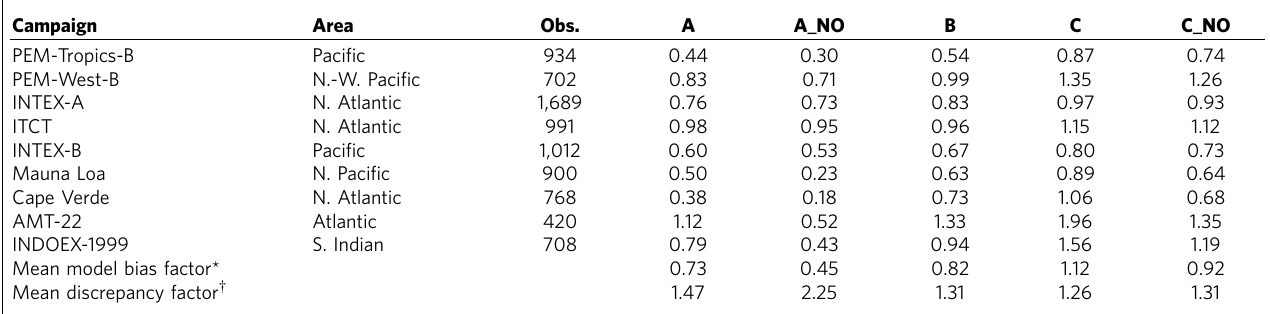
Table 5 | Measured CH 3 OH over oceans and model biases. Campaign Area